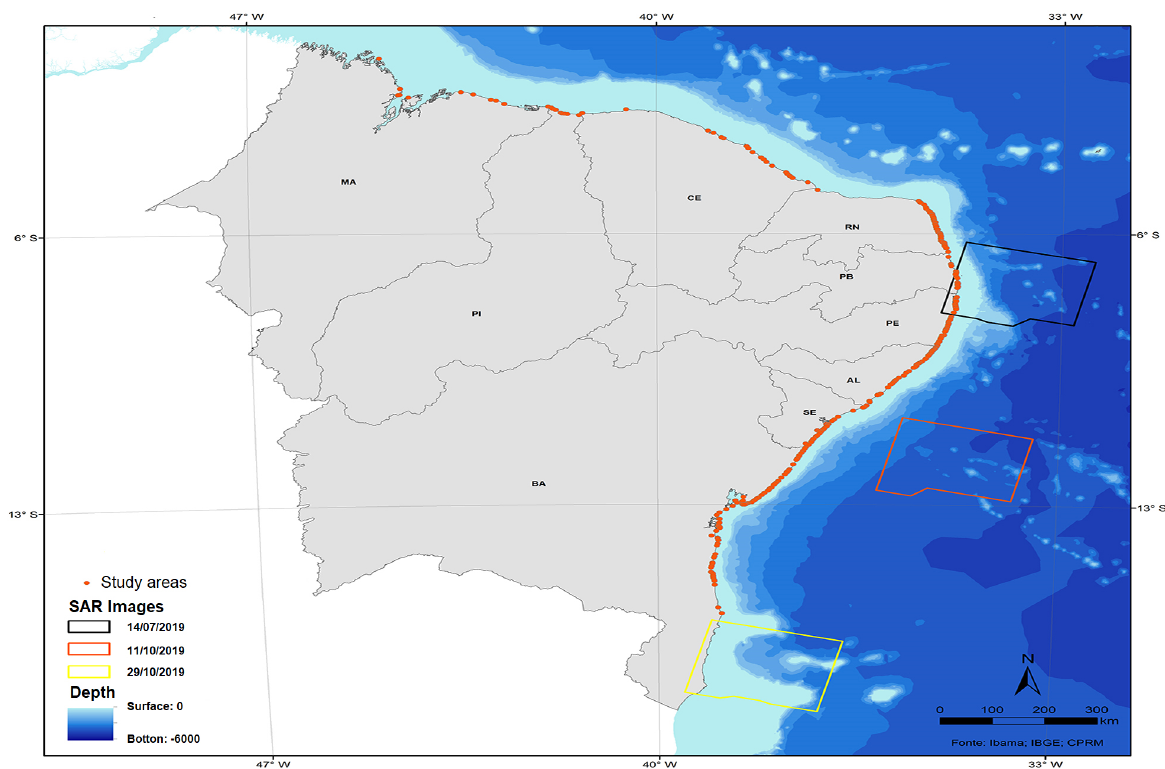
Figure 1. The study region shows oil spill landfall (orange circles) along the Northeastern Brazilian coastline for October 2019. The three Sentinel-1A SAR images used as test cases for look-alikes after the multilook